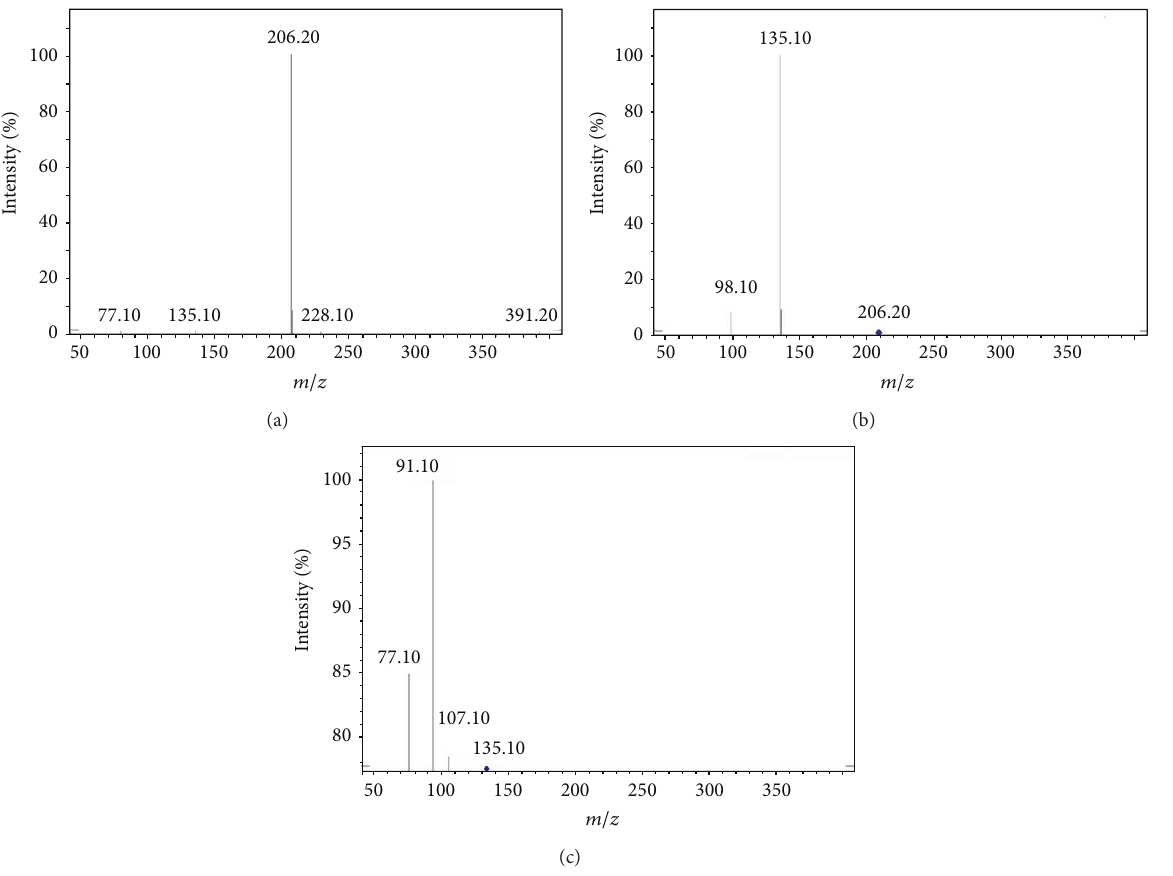
Figure 5: (a) Ion trap MS/MS mass spectrum of compound 4c [M + H] + ion ( m/z 206.20). (b) MS 2 spectrum of m/z 206.20. (c) MS 3 spectrum of